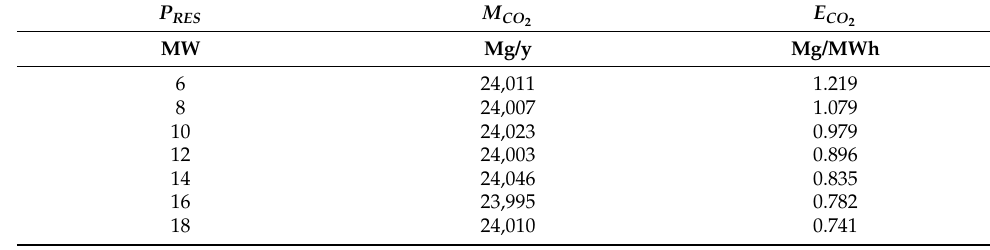
Figure 14. Emission factors of HGS, Polish power system, lignite and hard coal power plants.